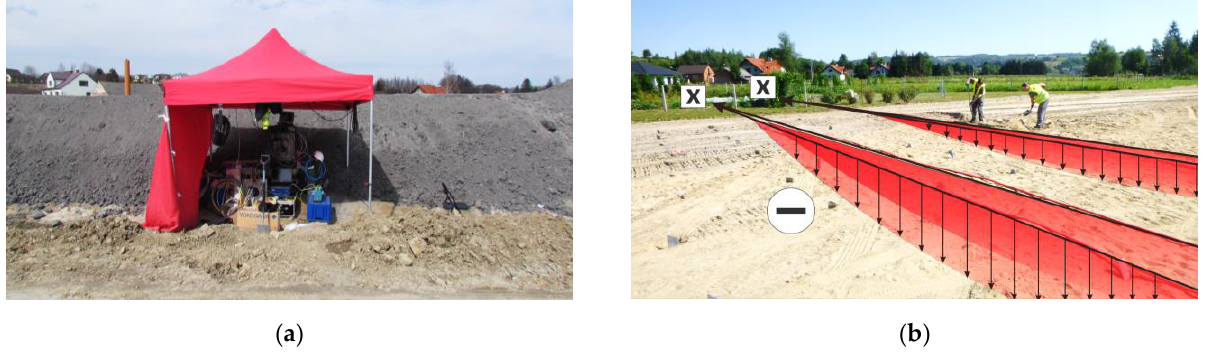
Figure 18. ( a ) The view of station next to the slope of embankment during one of the measurement sessions; ( b ) visualization of predicted displacement profiles with assumed signing (negative values correspond to downward displacements).